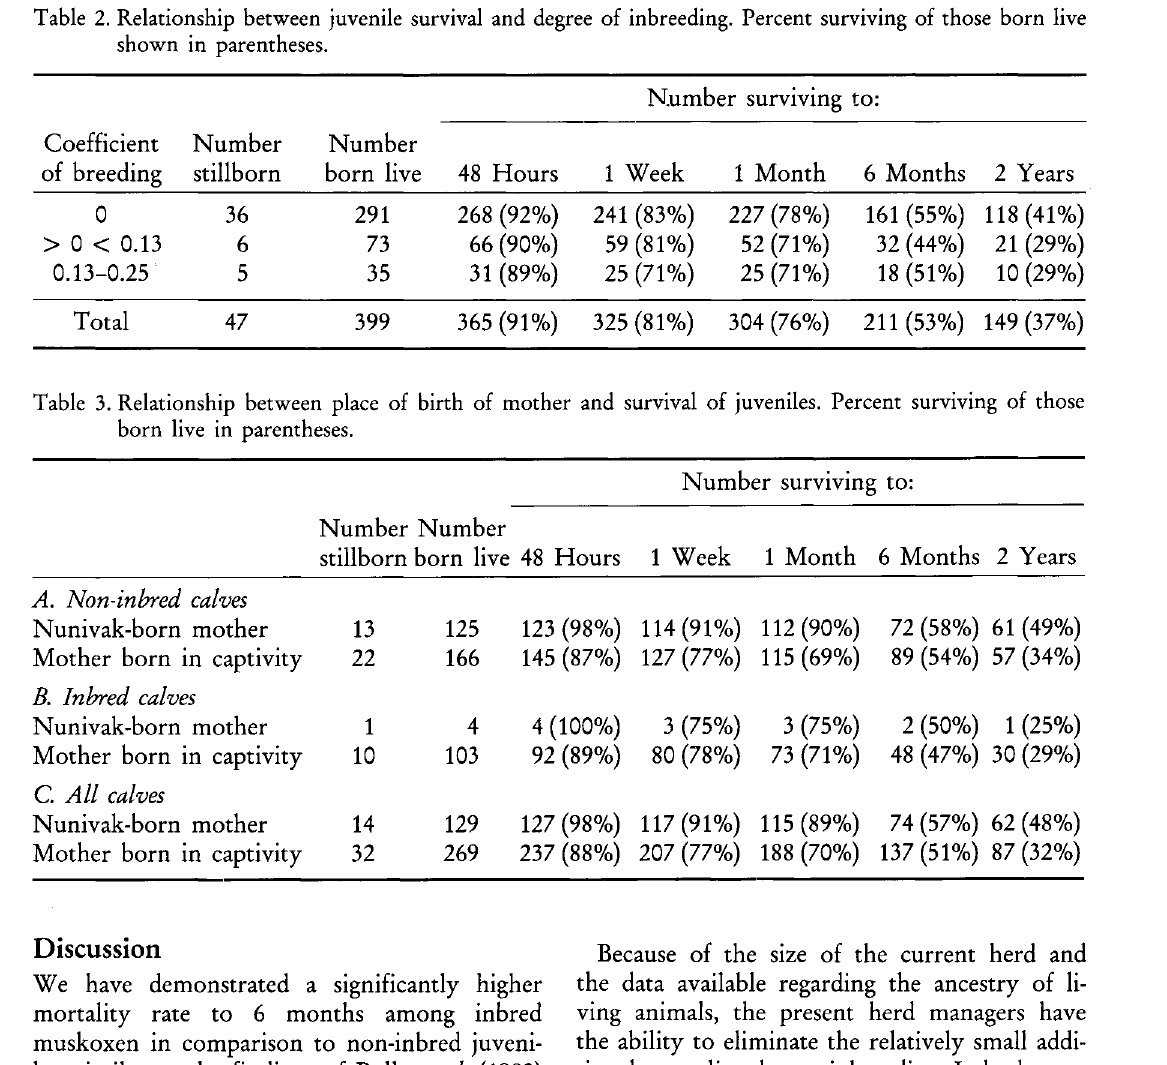
Table 2. Relationship between juvenile survival and degree of inbreeding. Percent surviving of those born live shown in parentheses.